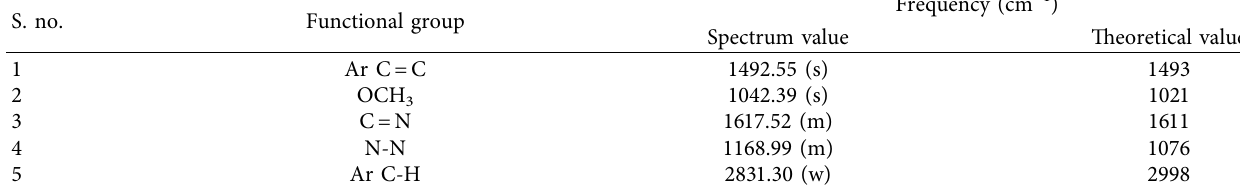
Table 1: FTIR measurements of DMBH.